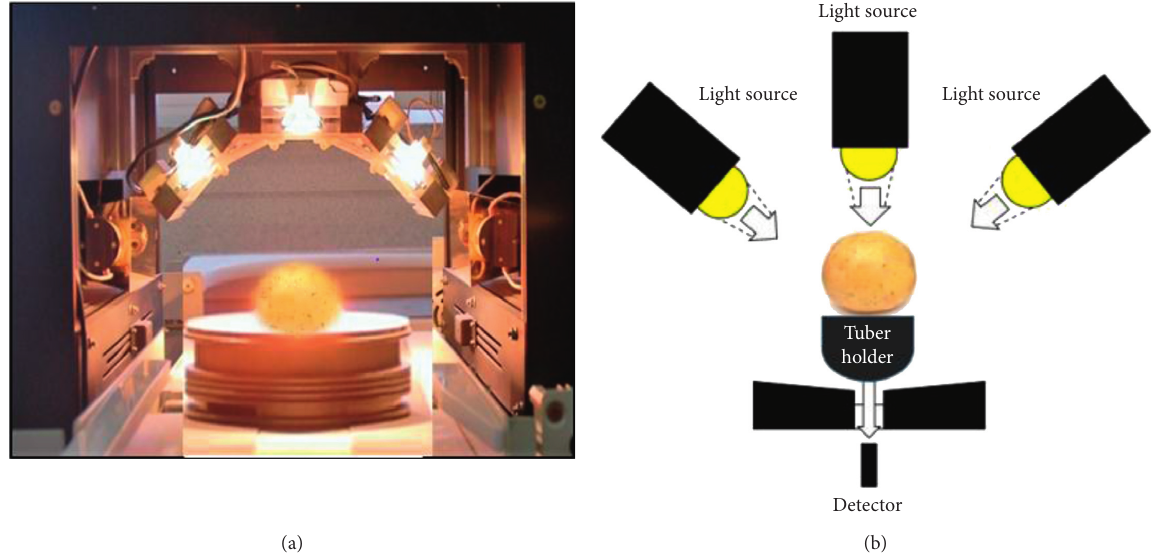
Figure 1: VIS/NIR spectrometer (a) and measurement system (b) during transmittance spectra measurement of intact potato tubers.